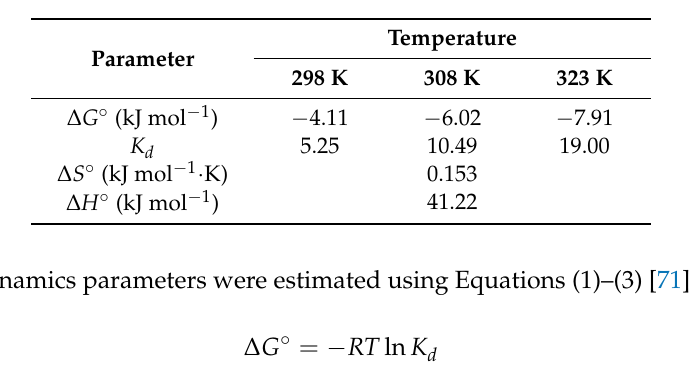
Table 8. Thermodynamic parameters of eosin removal using C16BrPG-2.40